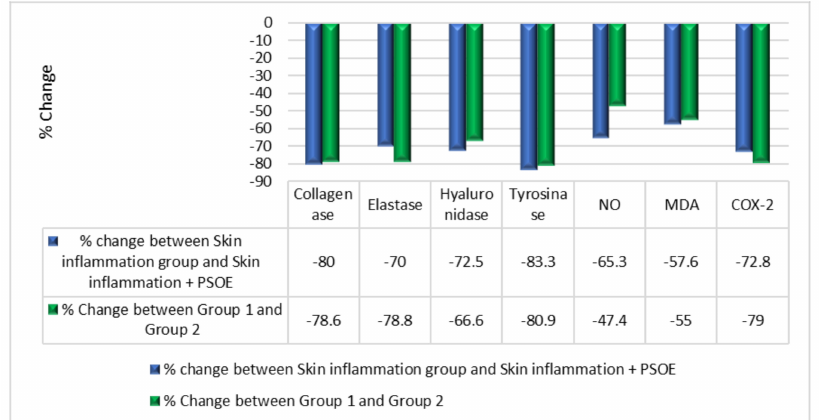
Figure 6. Comparison of beneficial effects of pomegranate seed oil extract (PSOE) between rat and human investigations. We compared the levels of collagenase, elastase, hyaluronidase, tyrosinase, nitric oxide (NO), malondialdehyde (MDA), and cyclooxygenase2 (COX-2) between the skin inflam- mation + PSOE group and the skin inflammation group (Group 1 and Group 2). We intramuscularly injected the rats in the skin inflammation group with a dose of phenobarbital (50 mg/kg body mass (bm)) once per week for three weeks, plus a daily dose of intracutaneous formaldehyde at 6 µ L/kg of body mass (bm). We orally administered rats in the PSOE group a daily dose of PSOE (250 mL/kg bm) for 21 days. The rats in the skin inflammation + PSOE group were injected with phenobarbi- tal, formaldehyde, and PSOE at the same dosages and in the same manner for three weeks, plus 250 mg/kg PSOE was administered directly to the inflamed part of the skin once per day for 21 days. Additionally, Group 1 did not receive any skin treatment (for at least 2–3 months); Group 2 was administered PSOE (250 mL/kg) as a skin treatment. In the human study, the treatments were administered directly to the inflamed part of the skin once per day for 21 days.